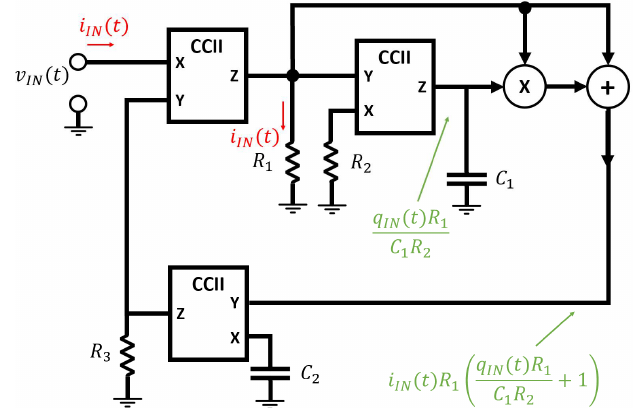
Figure 15. Meminductor emulator circuit based on current conveyors proposed by Fouda and Radwan